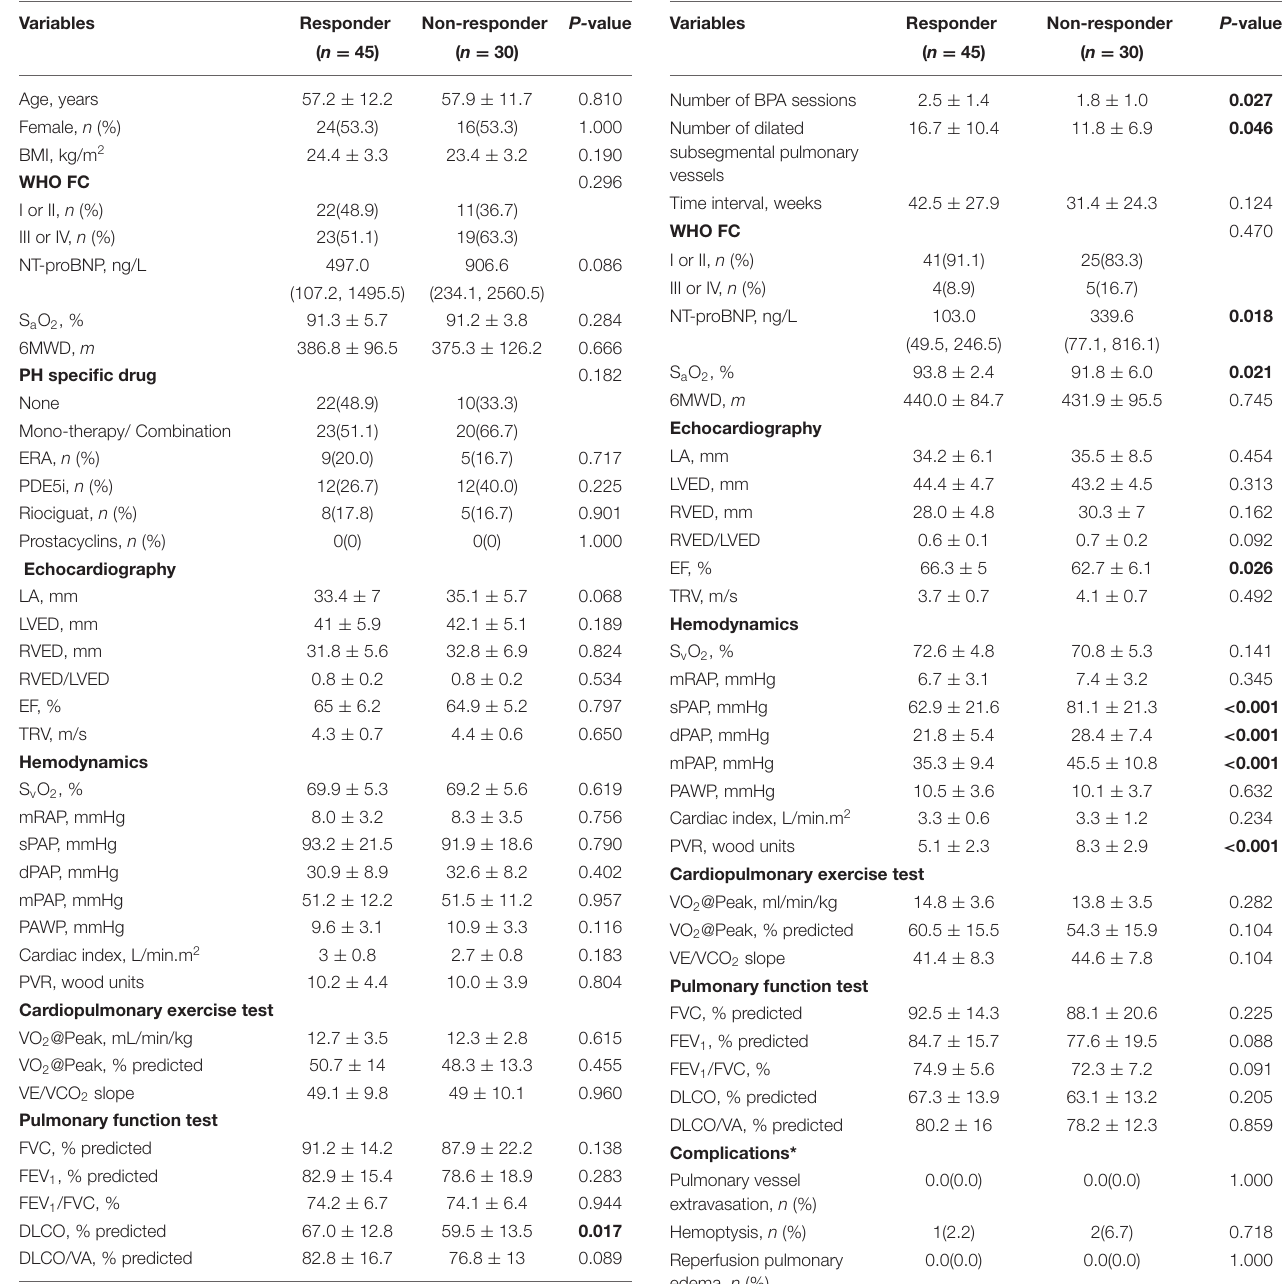
TABLE 1 | Clinical features of BPA responders and nonresponders at the baseline. TABLE 2 | Clinical features of BPA responders and nonresponders at